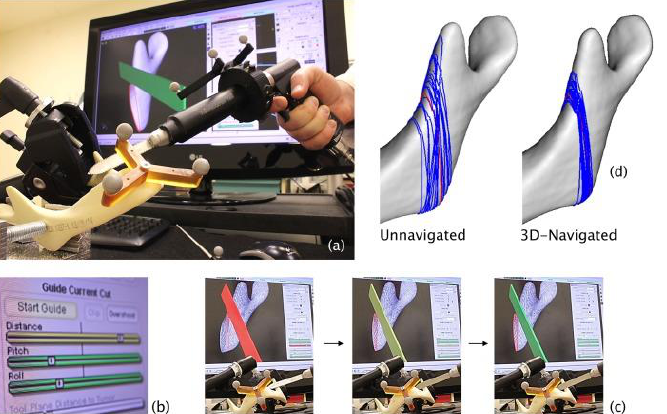
Figure 5. GTx-Eyes with a navigated saw ( a ) virtual cutting guide (red line) displayed on a CT reconstruction of the Sawbones mandible model, with navigated reciprocating saw correctly aligned (the saw blade is green) (bone anterior to the plane of the saw blade is clipped in the image so that the osteotomy plane can be visualized through the bone); ( b ) the indicators of distance, pitch and roll move and change in color from red to yellow and then green as the navigated saw is aligned precisely with the virtual cutting guide; ( c ) the saw blade also turns from red to yellow and then green as it is lined up correctly; ( d ) virtual cutting guide (red line) and unnavigated and 3D-navigated osteotomies (blue lines) after the analysis of multiple osteotomized models.